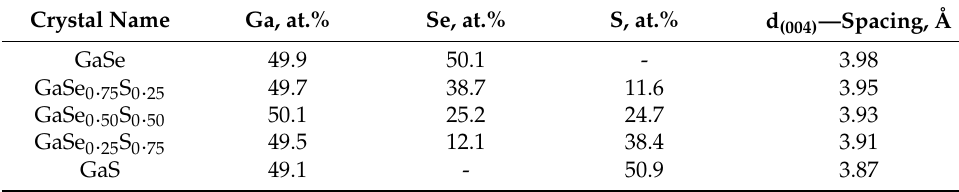
Figure 1. Optical ( a ) and SEM ( b ) images of the synthesized GaSe 1 − x S x crystals (scale bar 10 μm) . Table 1. Elemental composition and the d (004) — spacing of GaSe 1 − x S x crystals.